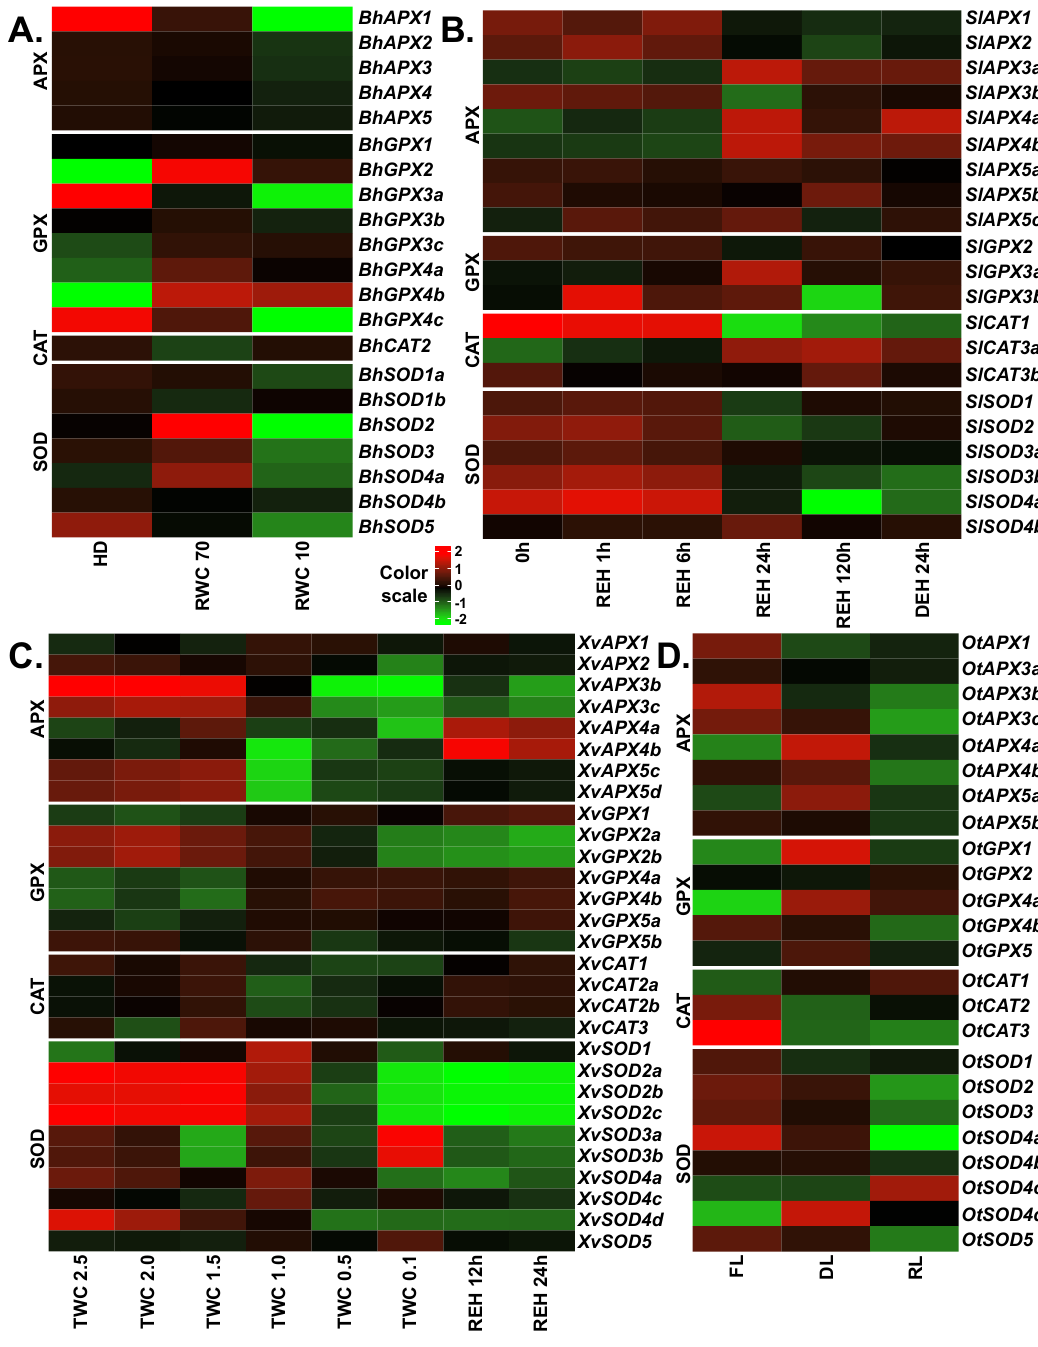
Figure 4. Expression profiles of APX , GPX , CAT and SOD genes upon desiccation stress in the resurrection species. The RNA-seq data from ( A ) Boea hygrometrica , ( B ) Selaginella lepidophylla , ( C ) Xerophyta viscosa and ( D ) Oropetium thomaeum were analyzed to obtain normalized expression values (TMM) for APX , GPX , CAT and SOD genes. Color scale represents the log 2 transformed and mean centered TMM values. Genes with low or no expression values were removed. HD: fully hydrated; RWC: relative water content; 0h: three years after desiccation; REH: hours after rehydration; DEH: hours after dehydration post-rehydration; TWC: turgid water content; FL: fresh leaves; DL: desiccated leaves; RL: rehydrated leaves. RWC is calculated as (fresh weight–dry weight) × 100 / (turgid weight – dry weight). TWC is the ratio of (fresh weight–dry weight) to dry weight.